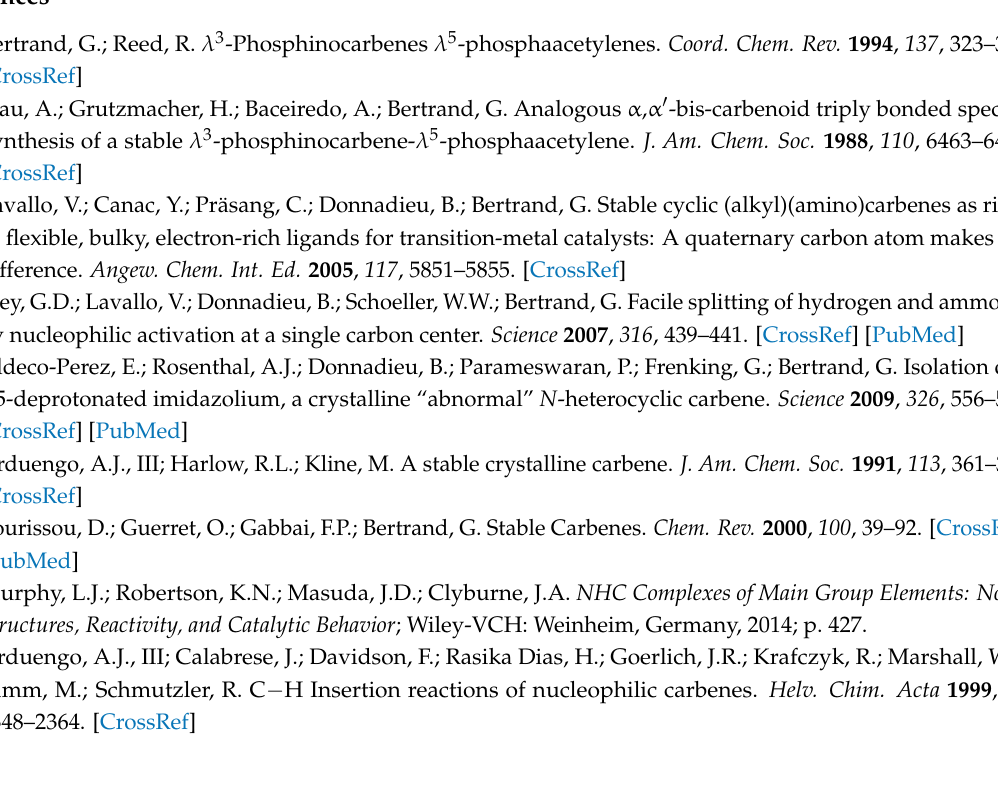
Figure S1: 1 H-NMR spectrum of SIPr(H)CCl 3 , Figure S2: 13 C{ 1 H} NMR spectrum of SIPr(H)CCl 3 , Figure S3. High resolution ESI mass spectrum of SIPr(H)CCl 3 , Table S1: Atomic coordinates and equivalent isotropic displacement parameters of SIPr(H)CCl 3 , Table S2: Bond lengths and angles for SIPr(H)CCl 3 , Table S3: Anisotropic displacement parameters for SIPr(H)CCl 3 , Table S4: Hydrogen coordinates and isotropic displacement parameters for SIPr(H)CCl 3 . Table S5. XYZ atomic coordinates for SIPr(H)CCl3 optimized at the B3LYP/6-311G(2d,p) level of